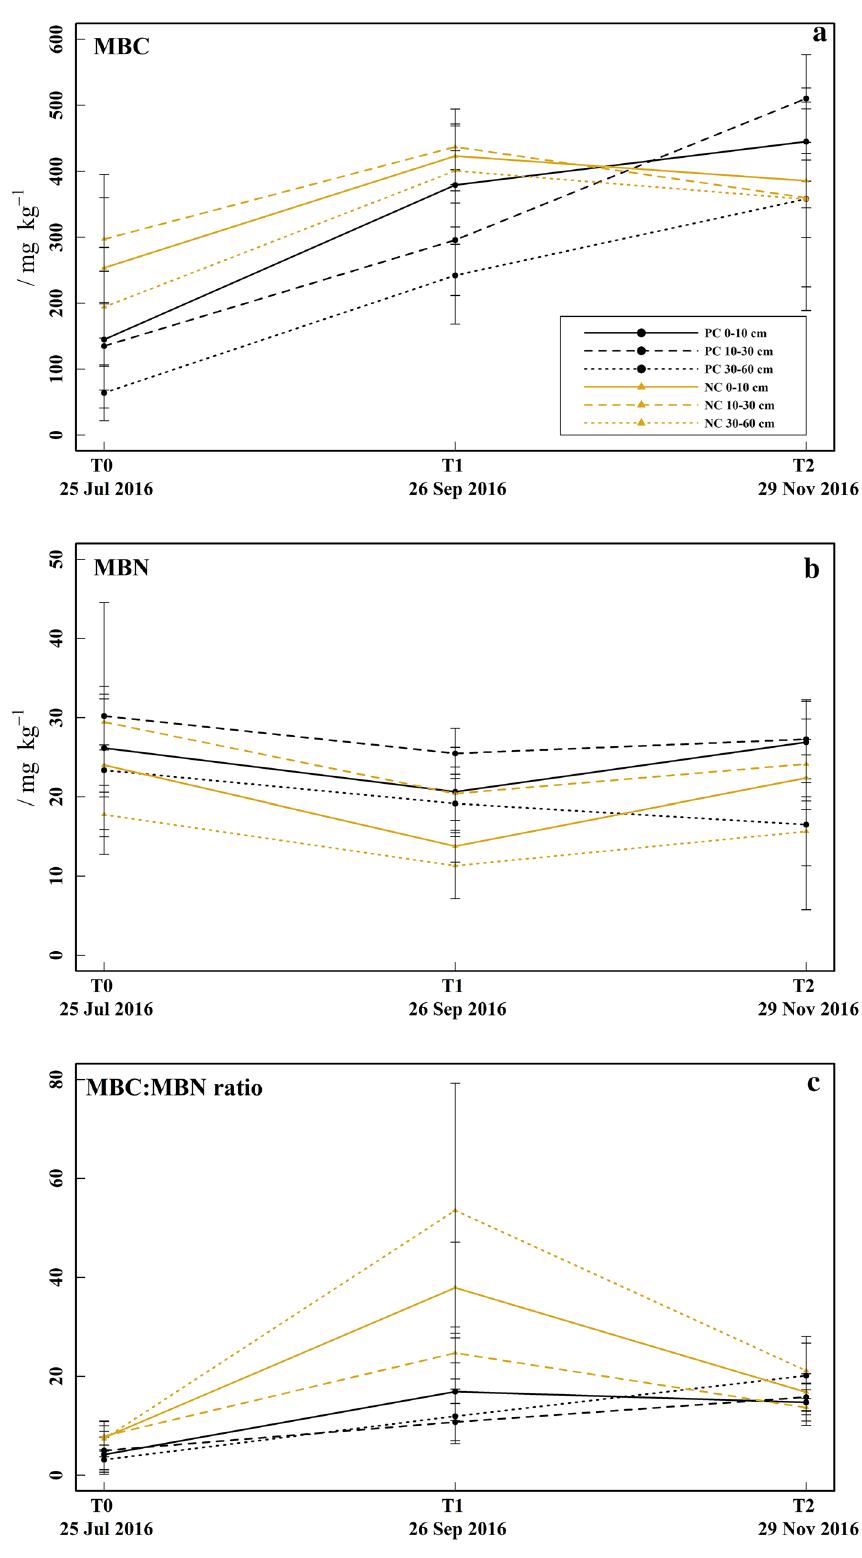
Fig. 4 Soil microbial biomass a Soil microbial biomass carbon (MBC) determined immediately after strawberry plantation (T0), 2 months (T1) and 4 months (T2) in the 0–10, 10–30 and 30–60 cm soil layer under plastic coverage (PC) and no coverage (NC), respectively, shown as mean with standard deviation (n = 5). b Soil microbial biomass nitro- gen (MBN), c MBC:MBN